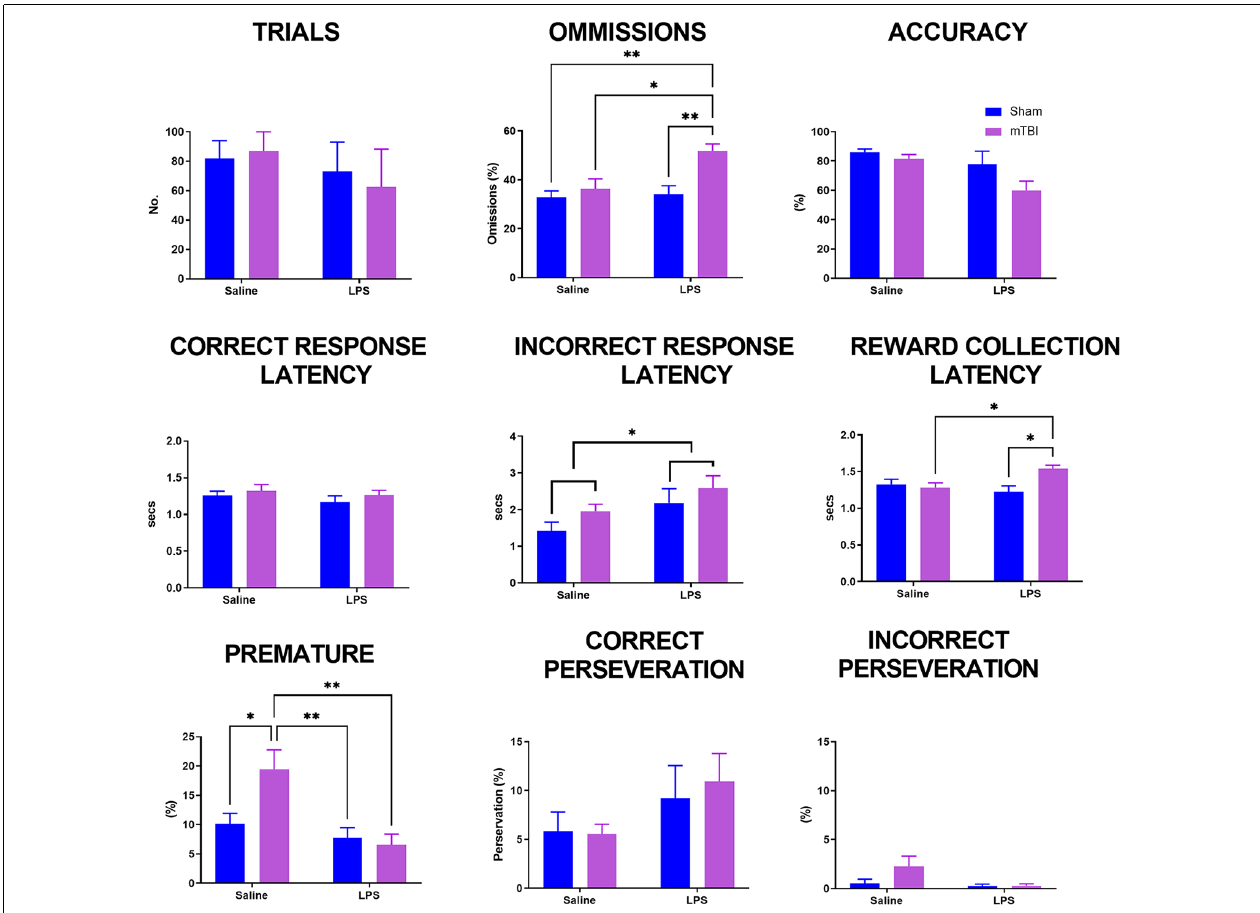
FIGURE 2 | Analysis of performance on the 5-CSRTT in a probe trial where stimulus duration was reduced to 2.5 s. Previously injured animals administered LPS had an increase in both omissions and reward collection latency. Following injury, animals had an increase in premature response rate which was prevented following administration of LPS (sham:saline n = 14, sham:LPS n = 12, mTBI:saline n = 14; mTBI:LPS n = 12). ∗ p < 0.05, ∗∗ p <